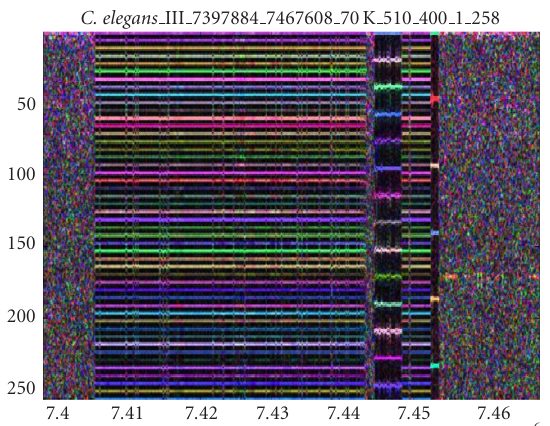
Figure 17: Spectrogram showing 40 kbp minisatellite in chromo- some X of D. melanogaster . The repeat length is 298 bp. Three strong interruptions can be seen as vertical lines just right of the